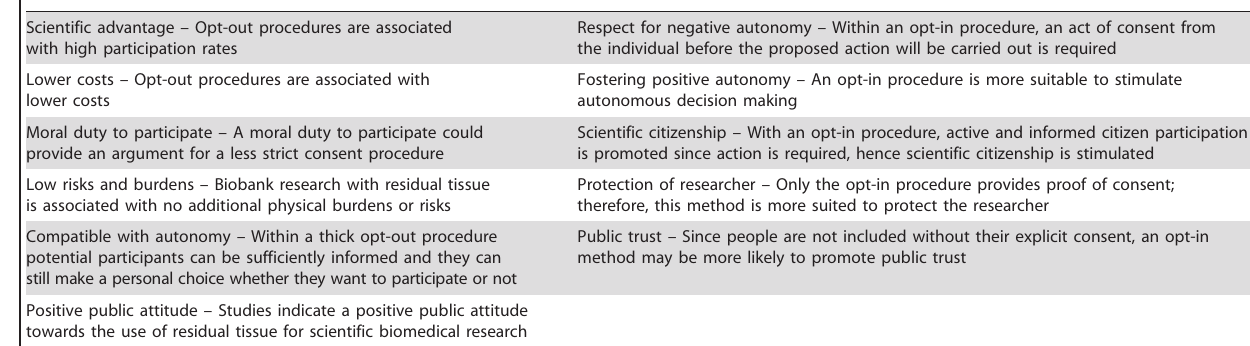
Table 1. Arguments in favor opt-in and opt-out